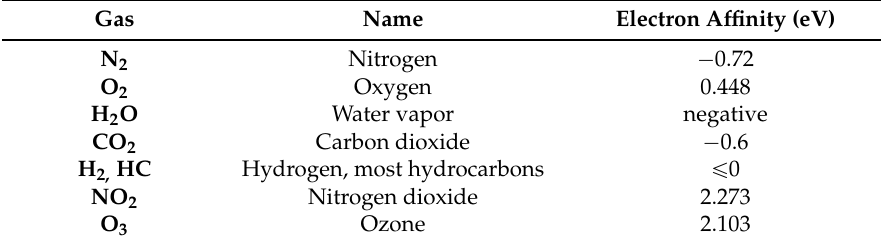
Table 2. Electron affinity of NO 2 relative to other molecular constituents of ambient air